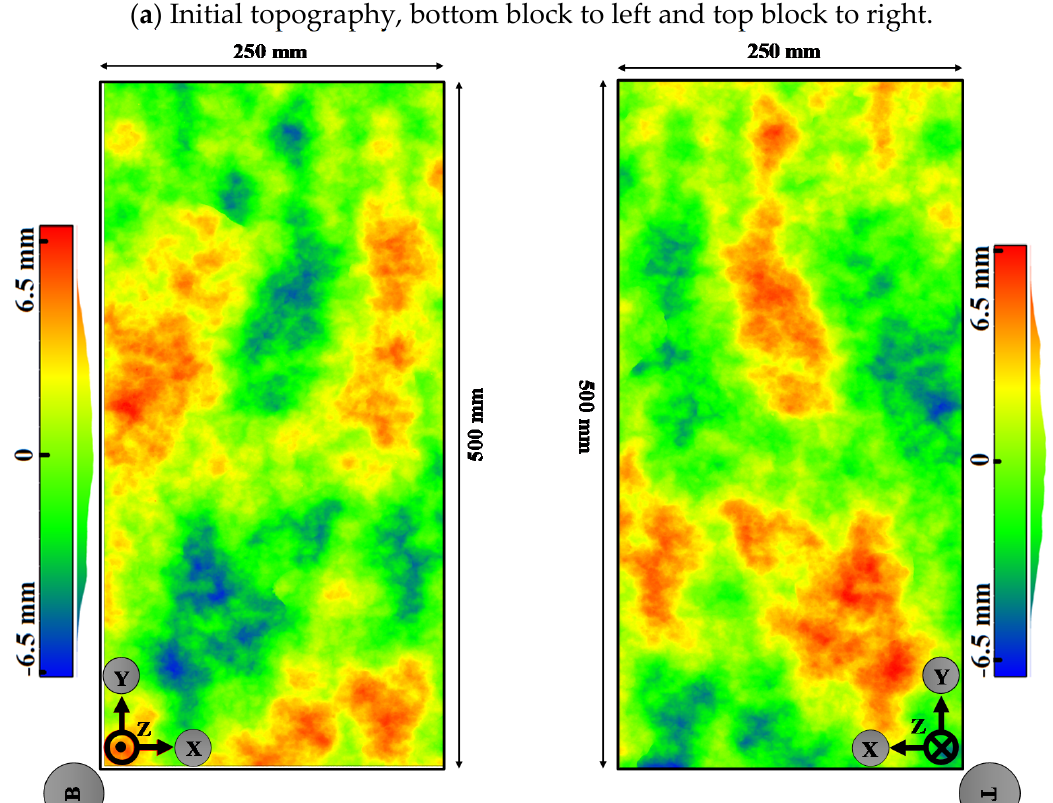
( a ) Initial topography, bottom block to left and top block to right.